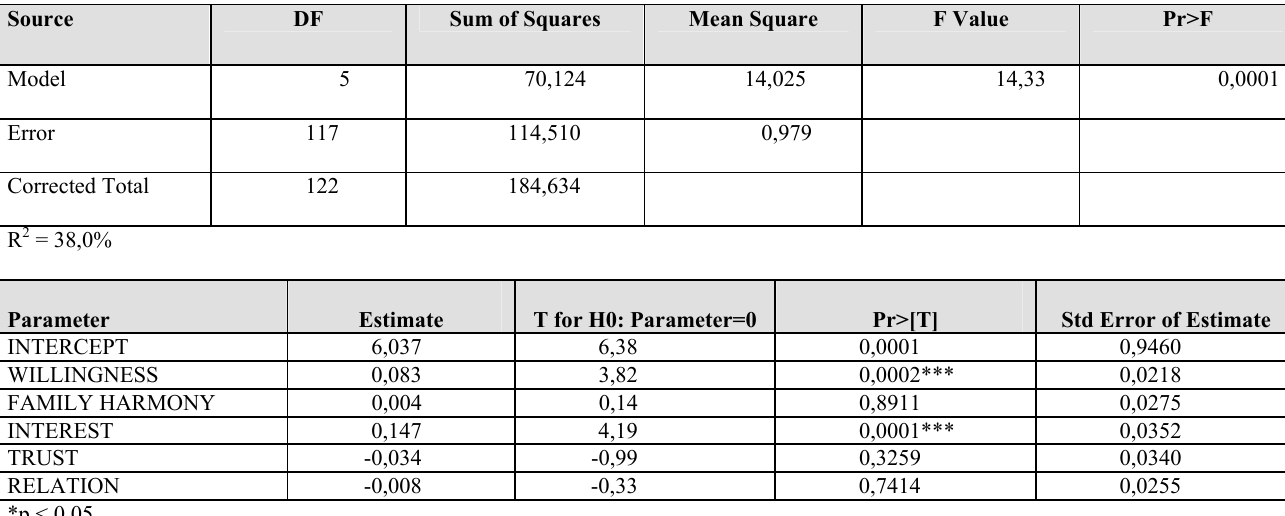
Table 3: Multiple regression results for owner-manager sub-sample: P rofitability Dependent Variable: